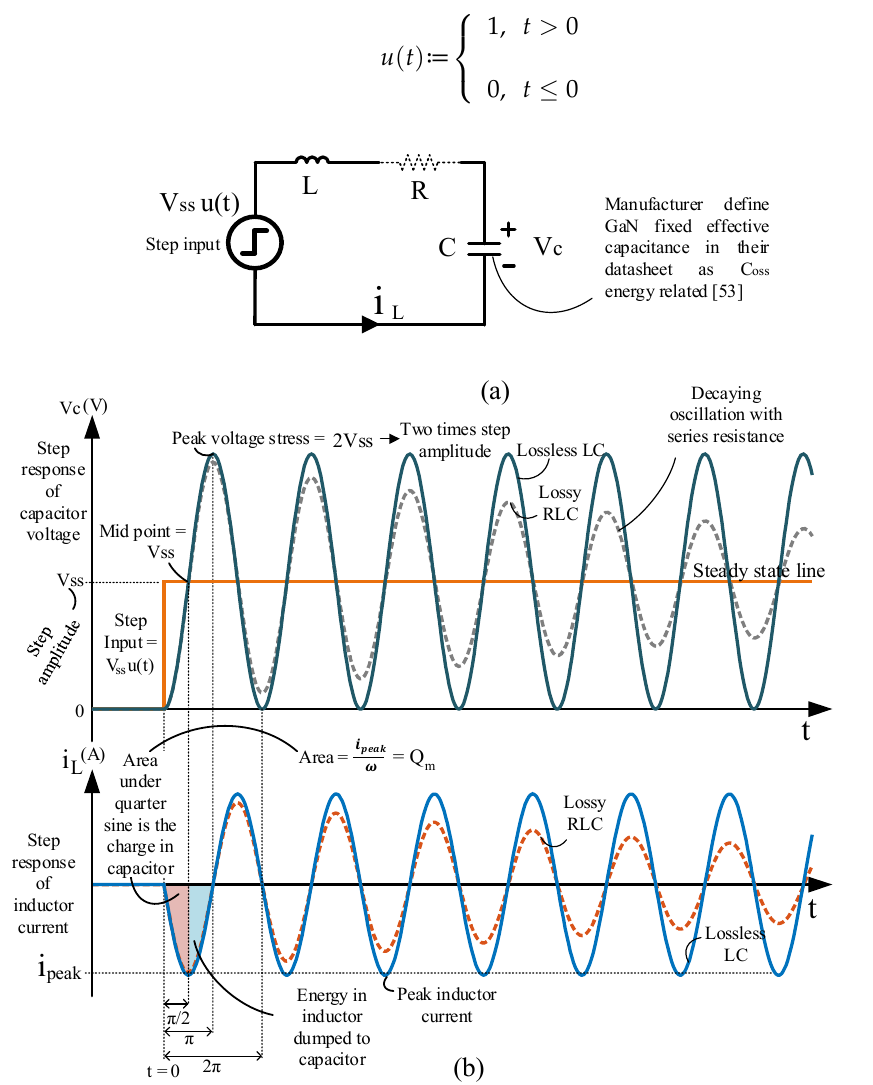
Figure A3. Fundamental of series LC circuit operation ( a ) the series LC resonance circuit (RLC in dotted lines) [53]. ( b ) The step response of LC circuit (RLC in dotted lines).